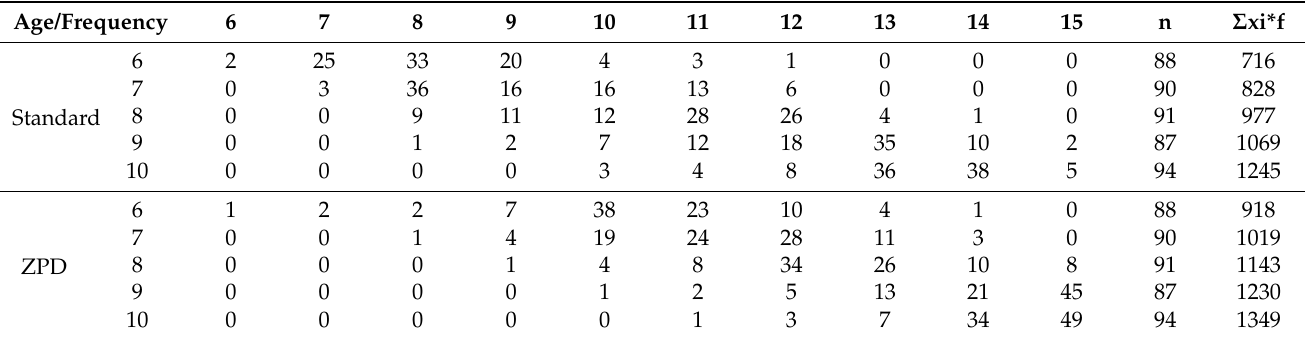
Table 2. Factor I: frequency distribution of the correct items and the sum modalities multiplied by frequencies in the standard and ZPD conditions in age groups.